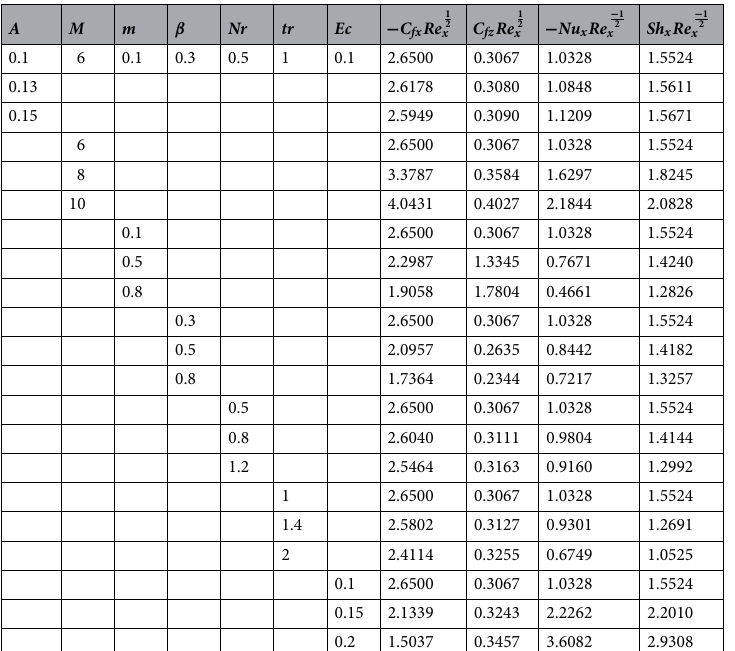
C fx and C fz (cid:31)